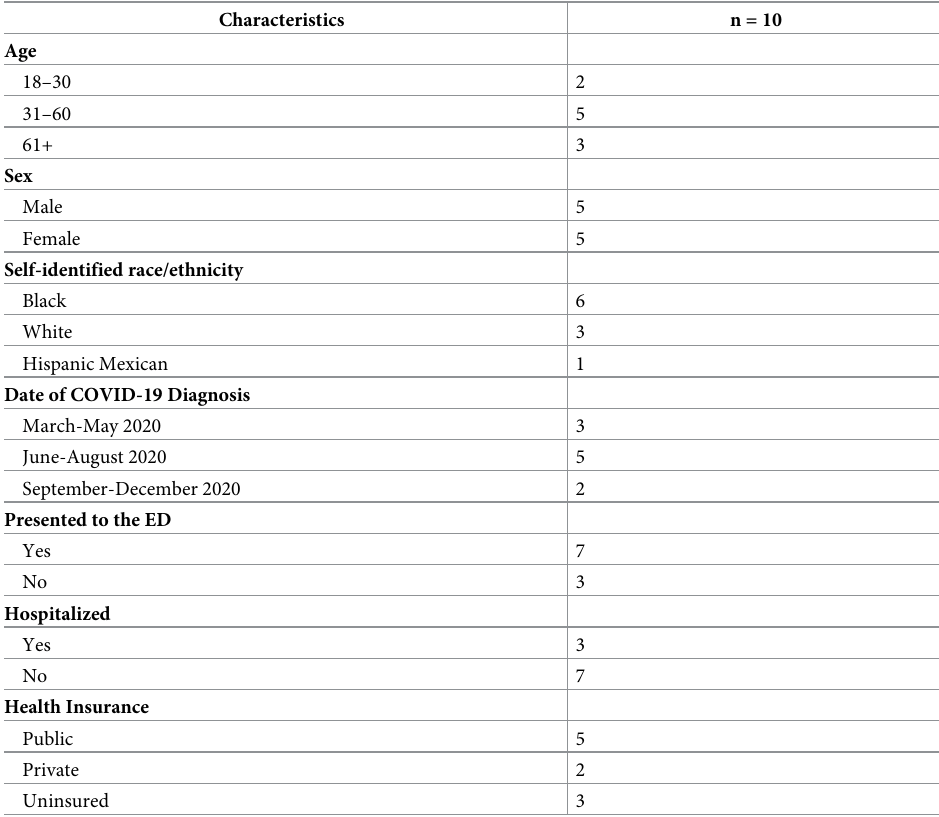
Table 1. Participant